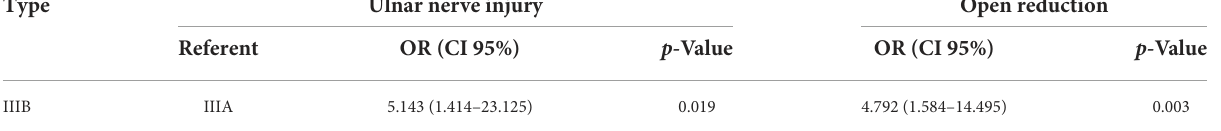
TABLE 2 Univariate odds of SCHF in different rotation fracture types.